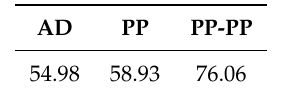
Table 2. Signal-to-Noise Ratio (dB) for the three different drive patterns.